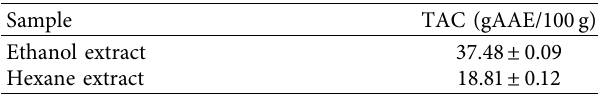
Figure 4: Mean absorbance of PMo V acid solution) against concentration of ascorbic acid solution. Table 5: Total antioxidant capacity of ethanol and hexane extracts expressed as gAAE.